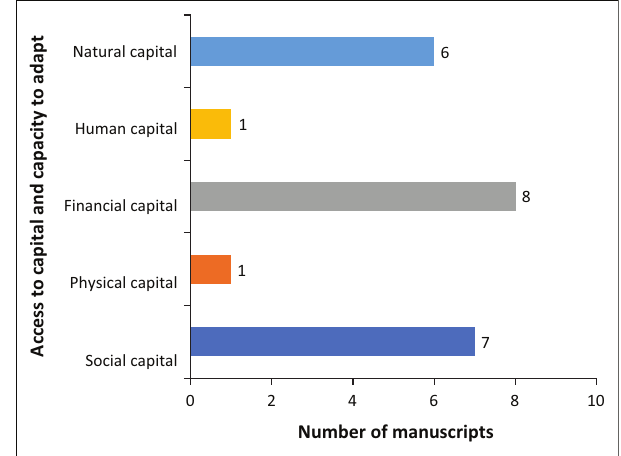
FIGURE 5: Enablers of resilience to the impact of COVID-19. FIGURE 6: Access to capital and capacity to